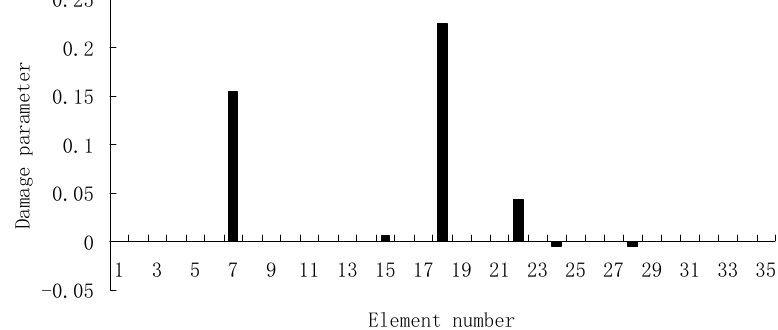
Figure 11. Damage evaluation result by the second computation of ESVT for case 2 (elements 7 and 18 had 15% and 20% stiffness reductions).